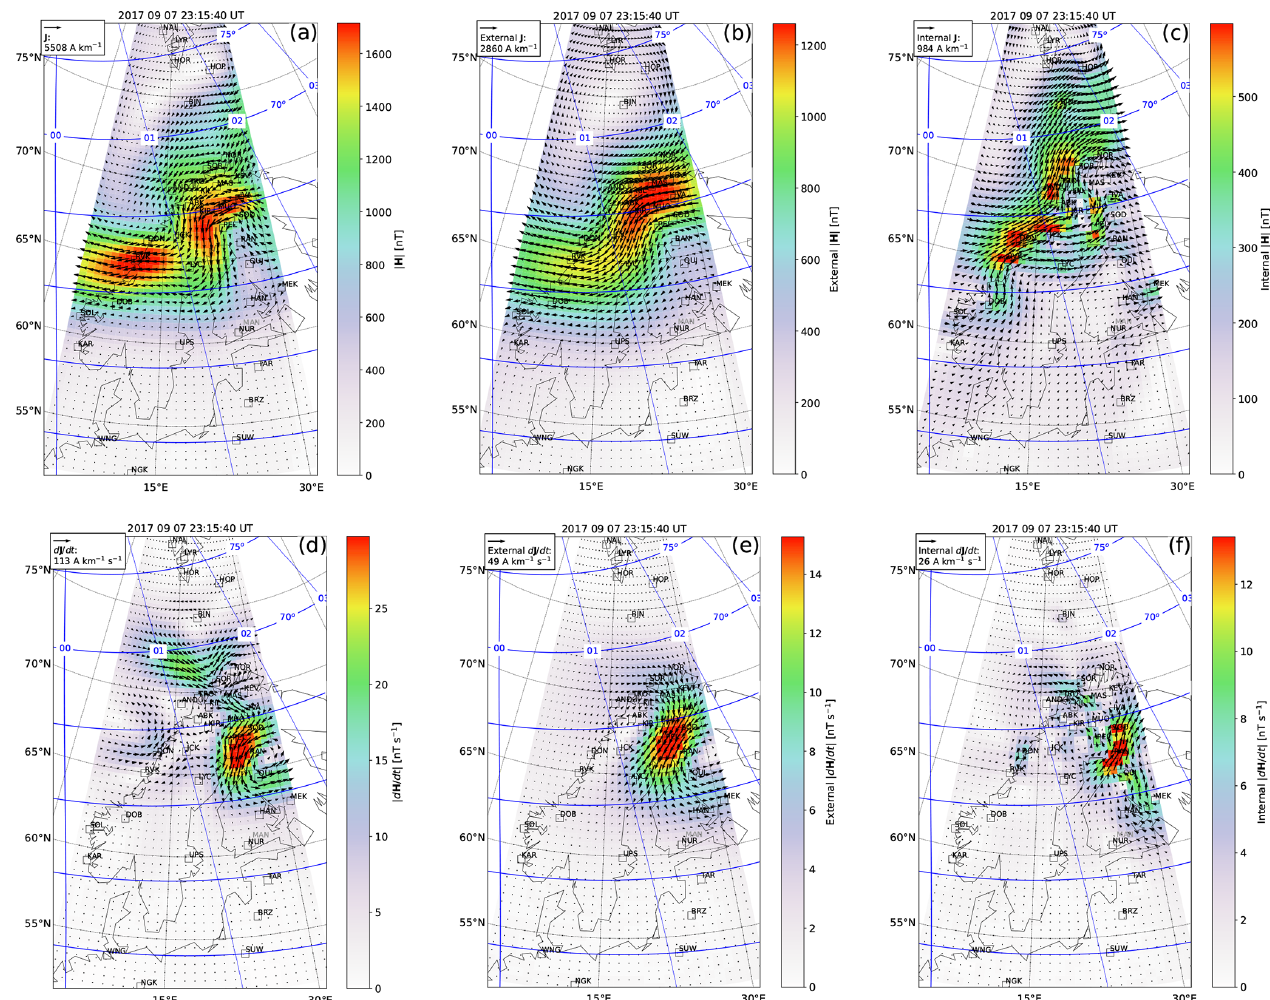
Figure 2. Effect of ground magnetic field separation: ionospheric equivalent current density (arrows) and corresponding horizontal ground magnetic field, calculated by fitting the measured ground north ( (cid:49)B x ) and east ( (cid:49)B y ) components of the geomagnetic field with a layer of 2D Spherical Elementary Current Systems (SECSs) (Vanhamäki and Juusola, 2020) at 90km altitude (a) . (b–c) Ionospheric (external) equivalent current density and corresponding ground magnetic field and induced (internal) equivalent current density and corresponding ground magnetic field, calculated by fitting the measured (cid:49)B x , (cid:49)B y , and (cid:49)B z with two layers of SECSs, one at 90km altitude and the other at 1m depth. (d–f) The same as (a) – (c) except for the time derivatives. Note that each panel has a different color and arrow length